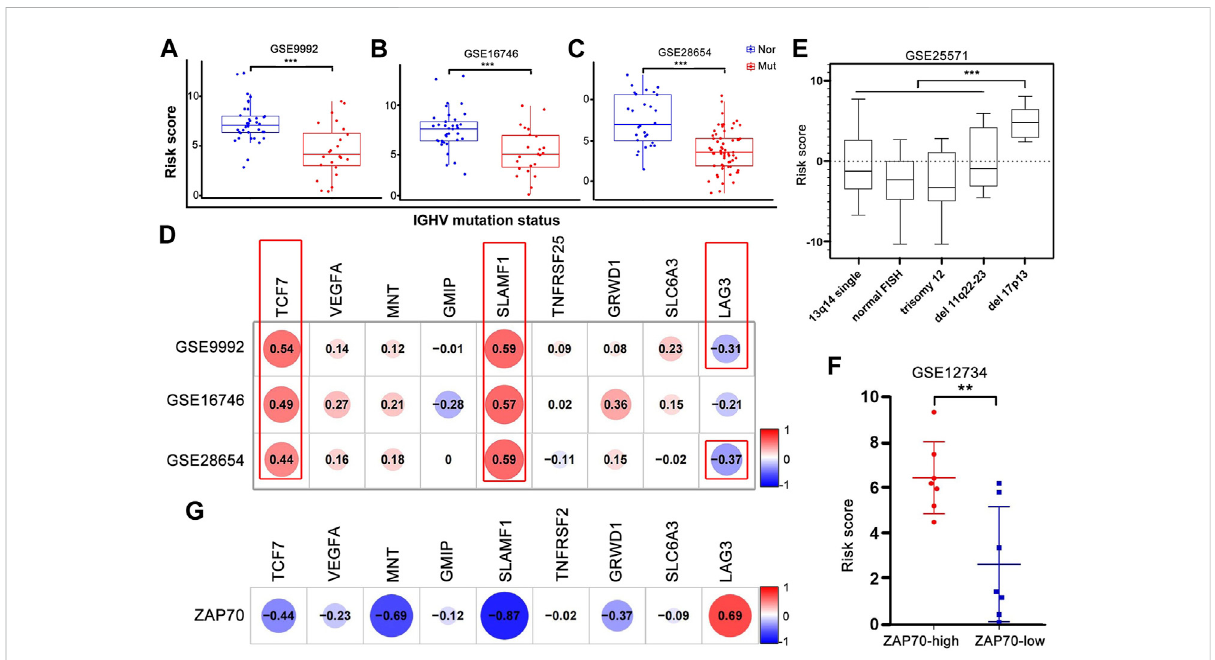
FIGURE 6 Correlationandvariancesbetweentheriskscoreoreachgeneexpressionandwell-establishedprognosticmarkersofCLL. (A – C) Theriskscore of patients with IGHV mutation was signi fi cantly lower than that of patients without mutation in GSE9992, GSE16746, and GSE28654. Nor, normal; Mut, mutation. (D) The correlation analysis of nine hub genes ’ expression and IGHV mutationstatue. The p -value in red box < 0.001, respectively. (E) The risk score of patients with del17p13 was signi fi cantly higher than that of other chromosome abnormalities. *** p < 0.001. (F,G) The different level of risk score in high- and low-ZAP70 patients and the correlation between nine hub genes ’ expression and ZAP70